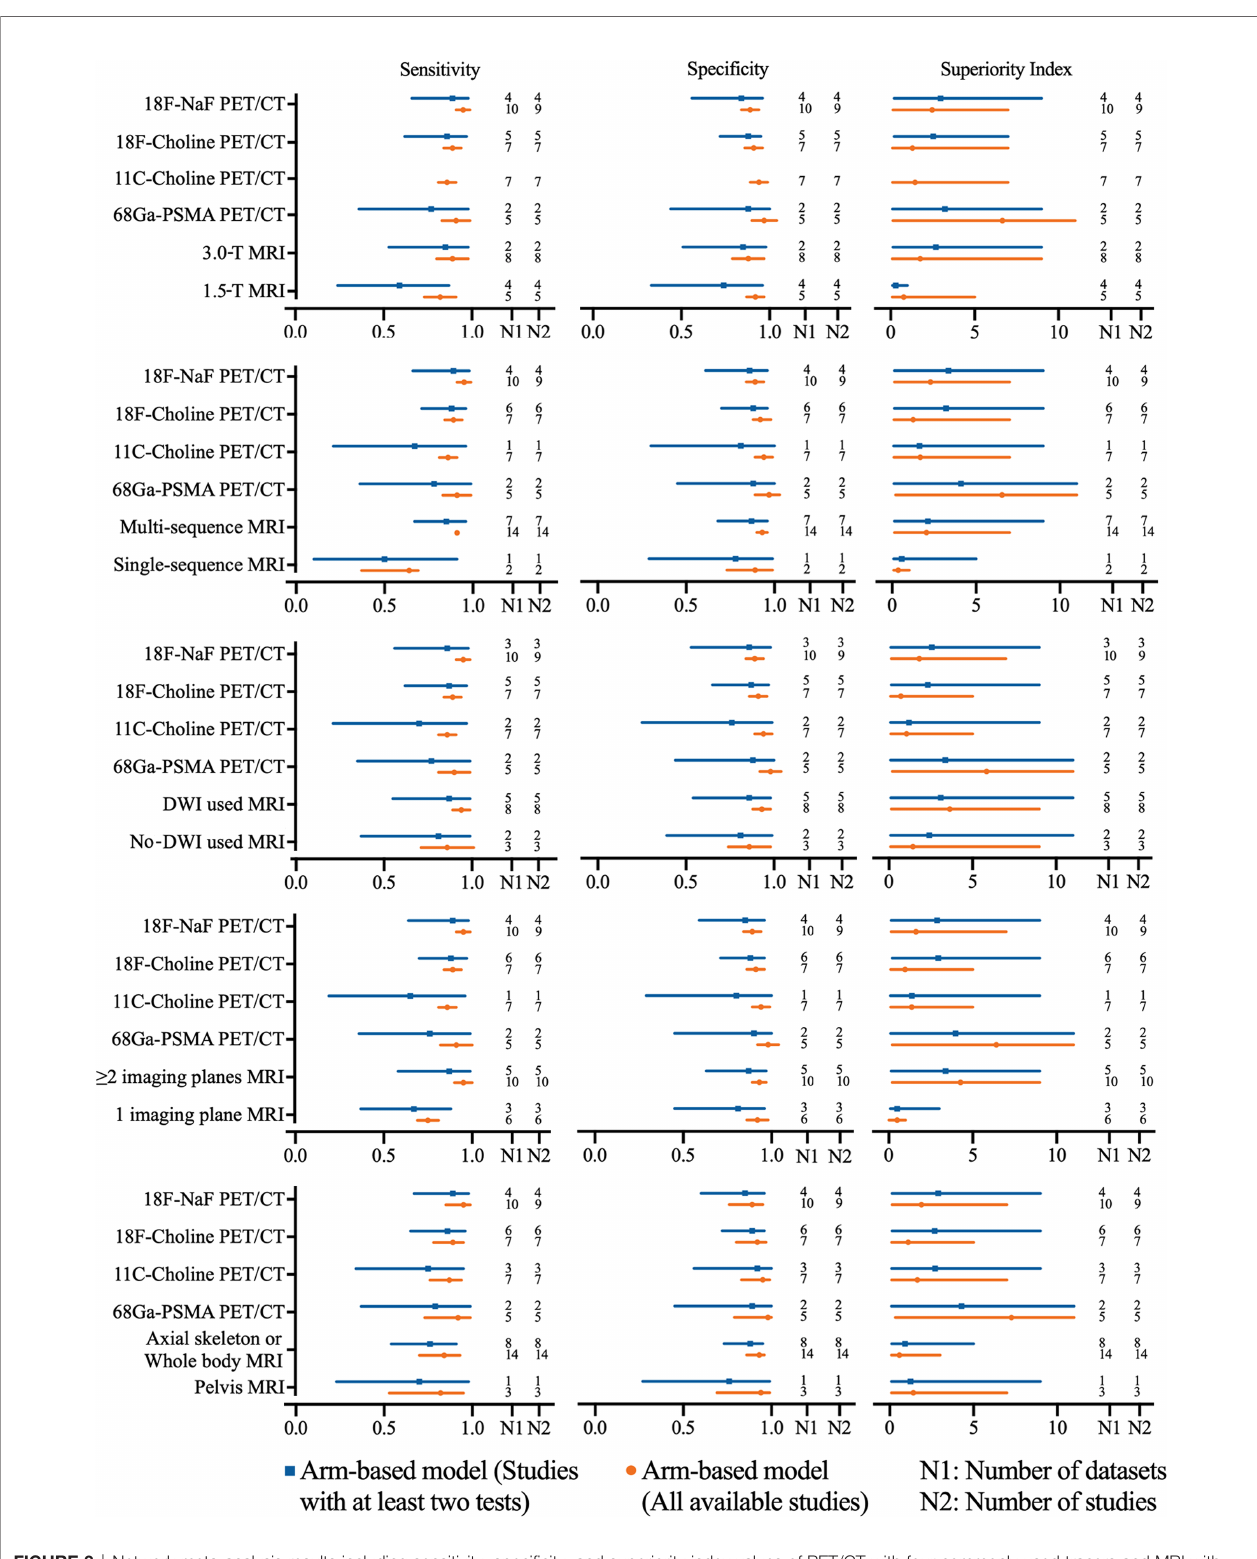
Frontiers in Oncology |